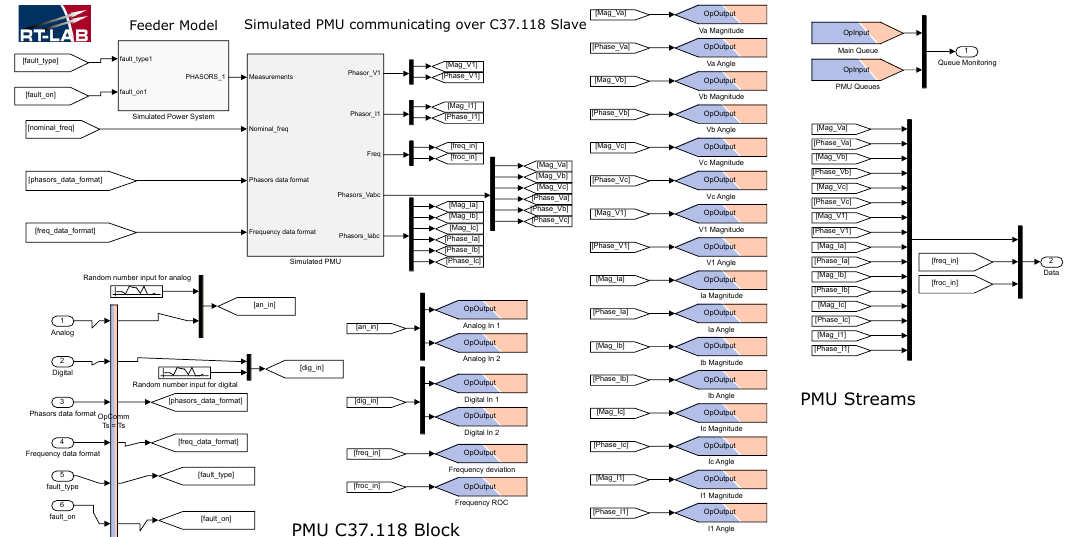
Figure 9. RT-lab/simulink model for the PMU C37.118